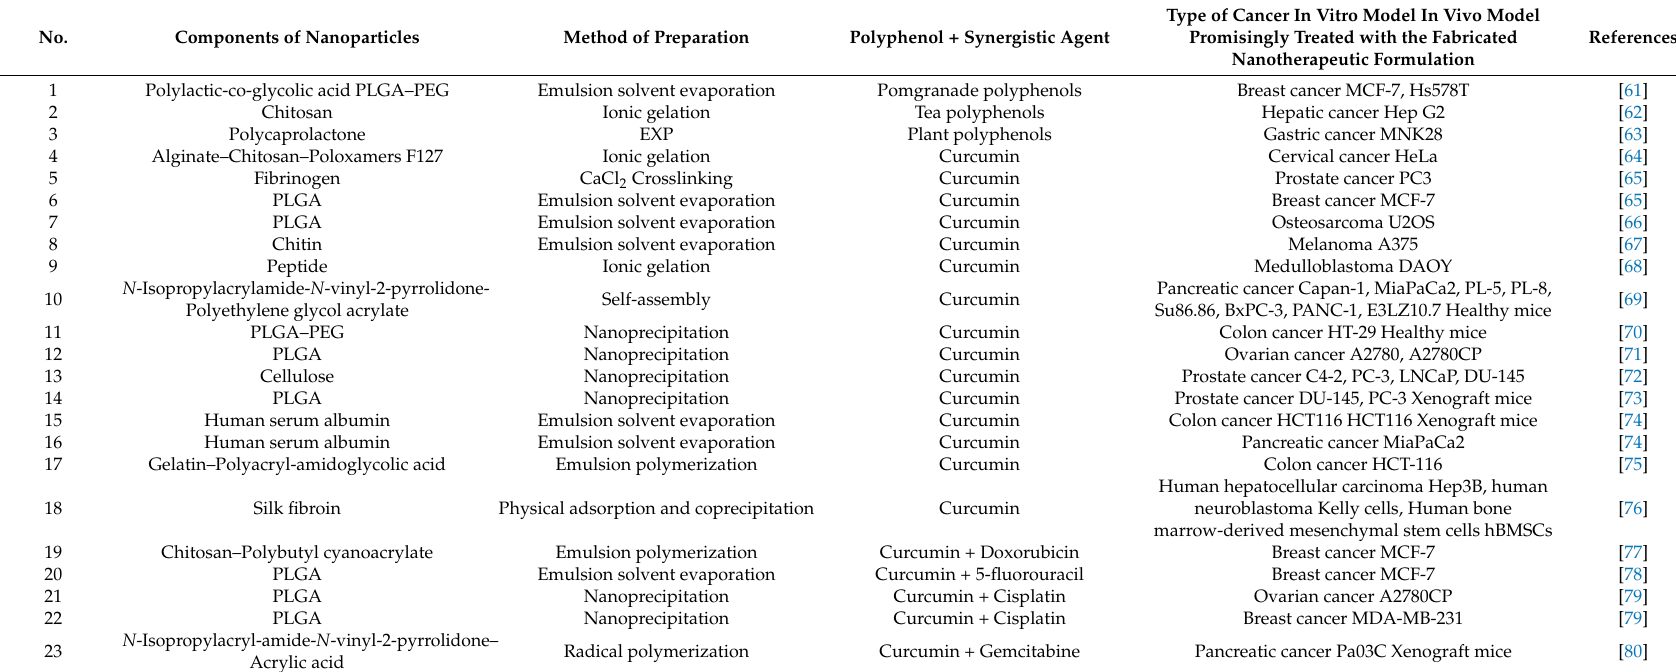
Table 3. Polyphenol-loaded polymeric nanoparticles for the treatment of cancer in